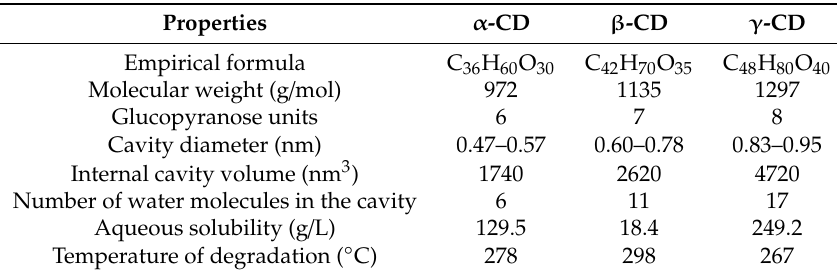
Table 1. Some physicochemical properties of cyclodextrins